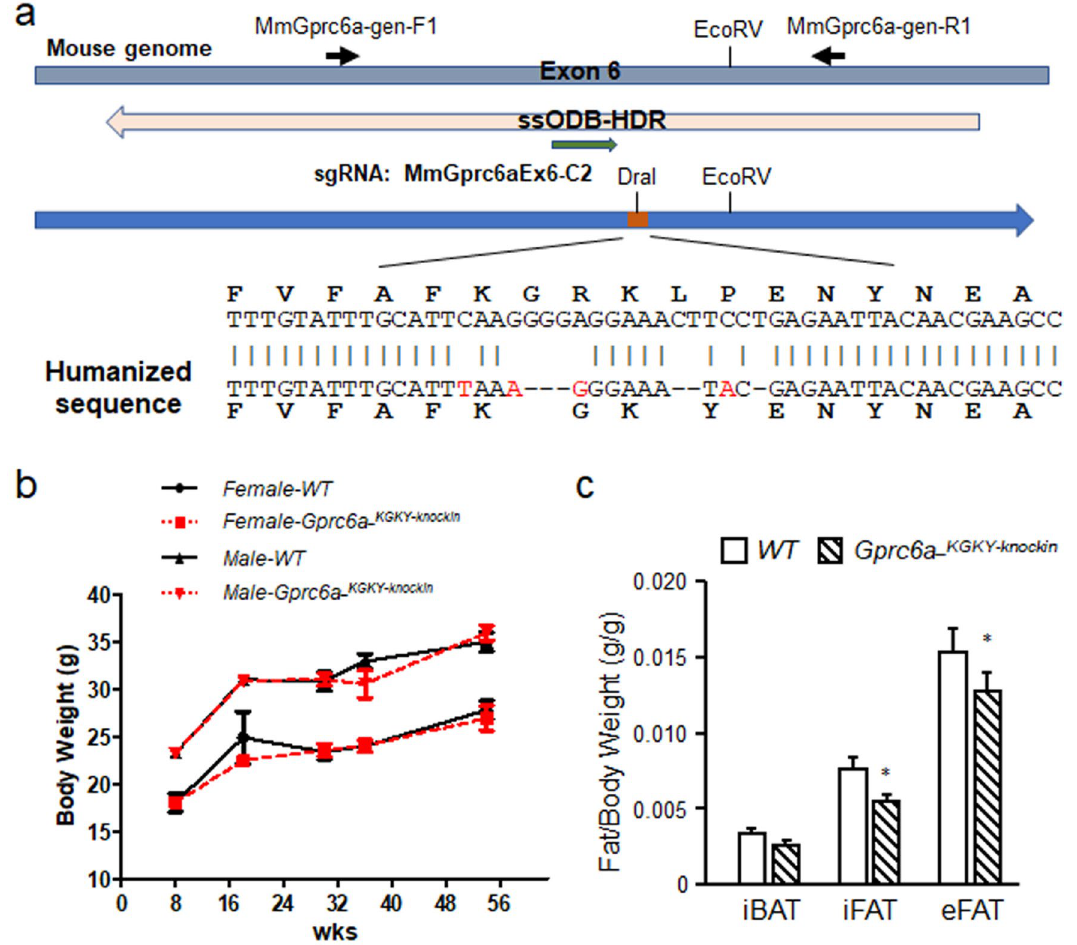
Figure 1. Creation of Gprc6a- KGKY-knockin mice. ( a ) Structure of Gprc6a exon 6, knockin sequence and genotype primers and Dra I restricted enzyme location. The orange box shows the KY location in blue arrow. The yellow arrow shows the ssOBD-HDR location. The green arrow shows sgRNA location. ( b ) Comparison of the body weight in wild type and Gprc6a- KGKY-knockin mice at age from 8 to 54 weeks. ( c ) Site specific brown and white fat content in 20 week-old male mice. Interscapular brown fat (iBAT) and white inguinal fat (iFAT) and epididymal fat (eFAT). Values represent the mean ± SEM. *Significant difference between wild type mouse Gprc6a- RKLP and Gprc6a- KGKY-knockin mice ( P < 0.05, Student’s t test; n =